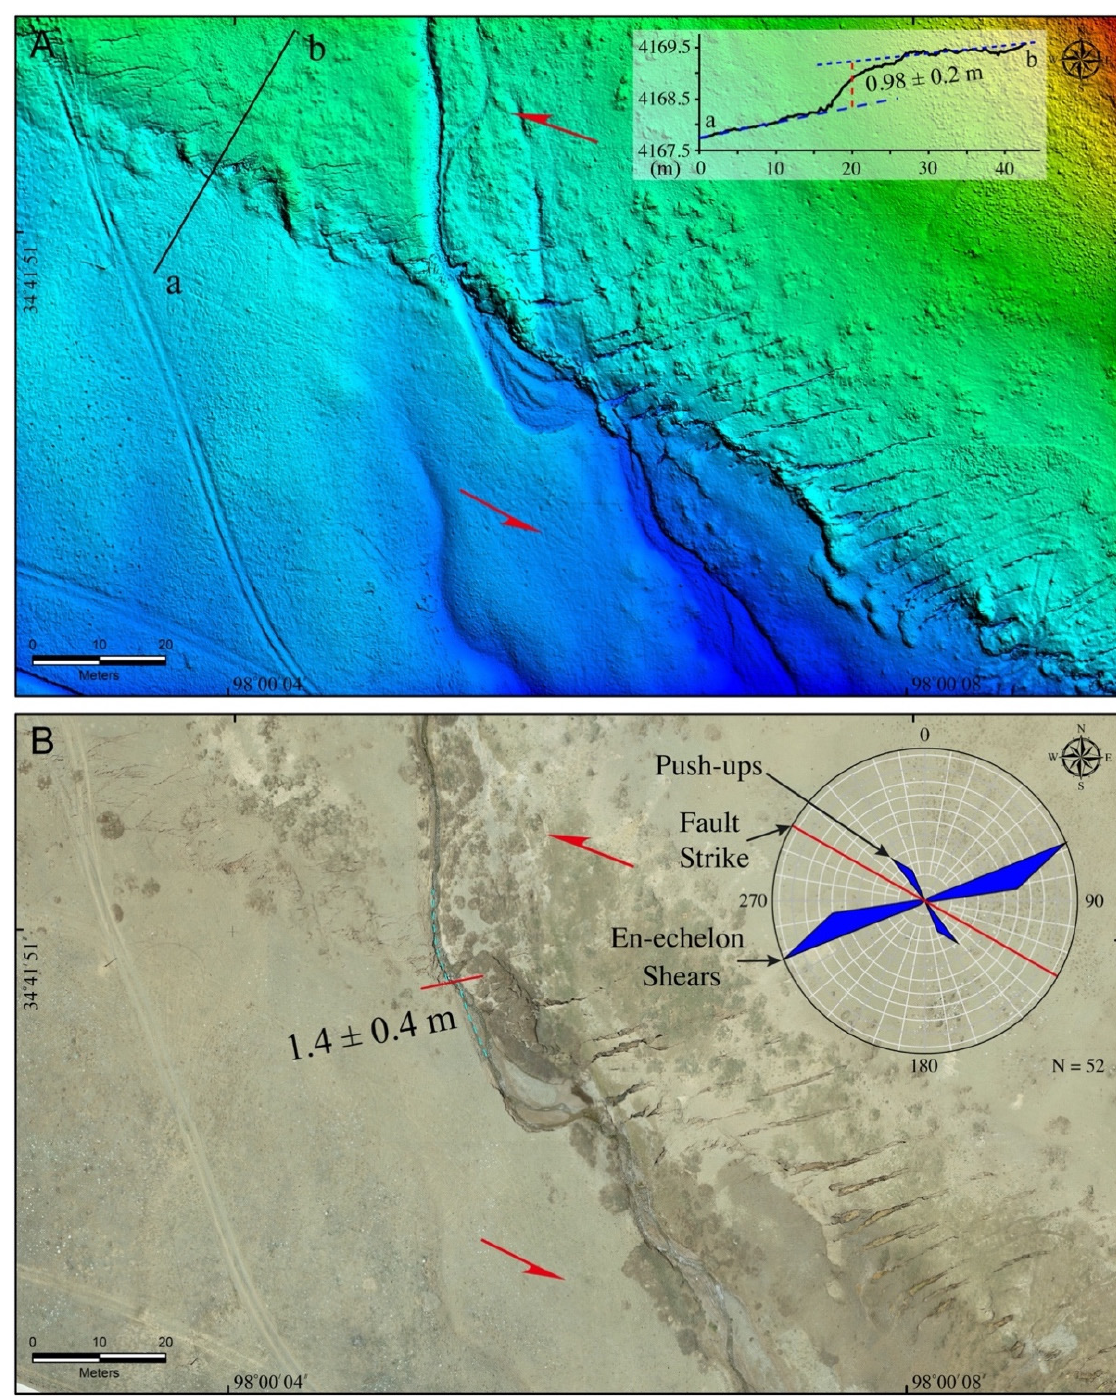
Figure 7. ( A ) DEM and ( B ) orthophoto of a fault scarp that ruptured during the earthquake. The height of the scarp is about 1 m in ( A ). En-echelon shears and push-ups are major structures. A gully is visibly displaced. The offset along the shear strike is 1.4 m, the included angle θ between shear strike and fault strike is 40°, then the offset along the fault strike equals to 1.4/cos(40°), which is about 1.8 ± 0.4 m.